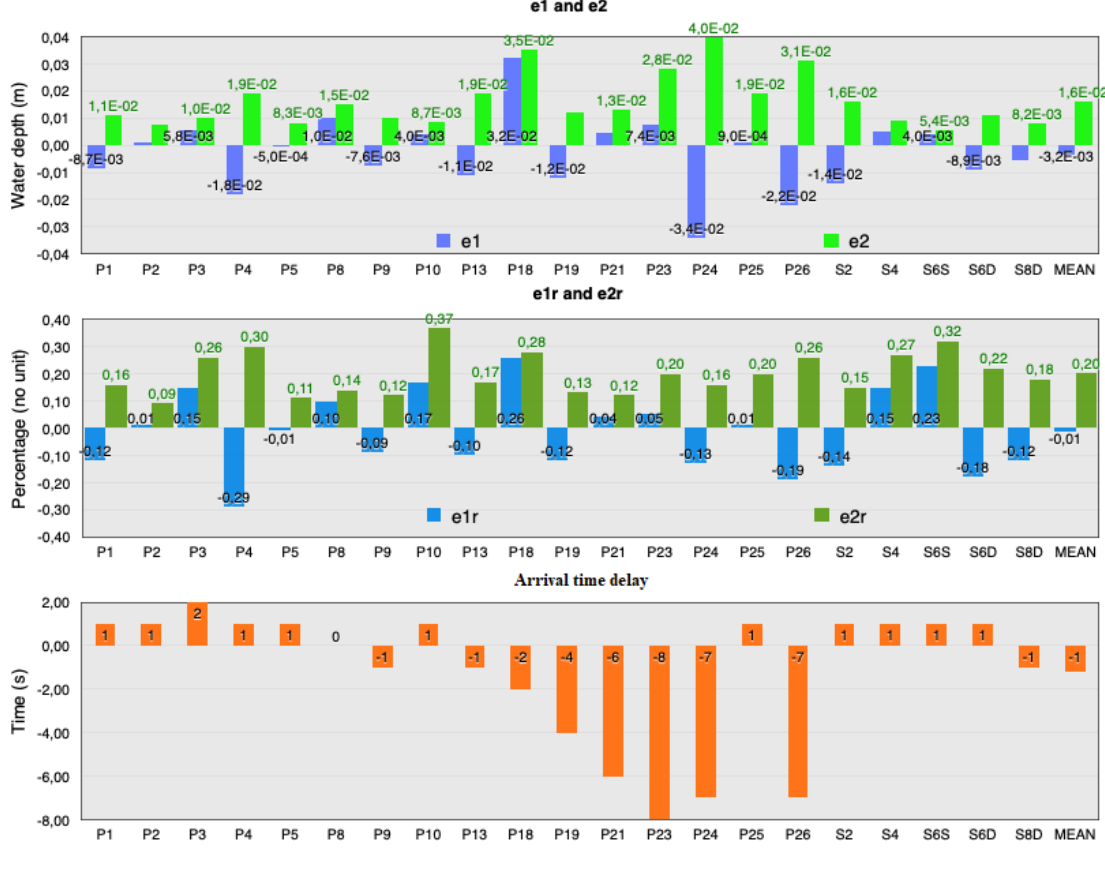
Figure 10. Error norms and arrival time delay with respect to the gauge stations.